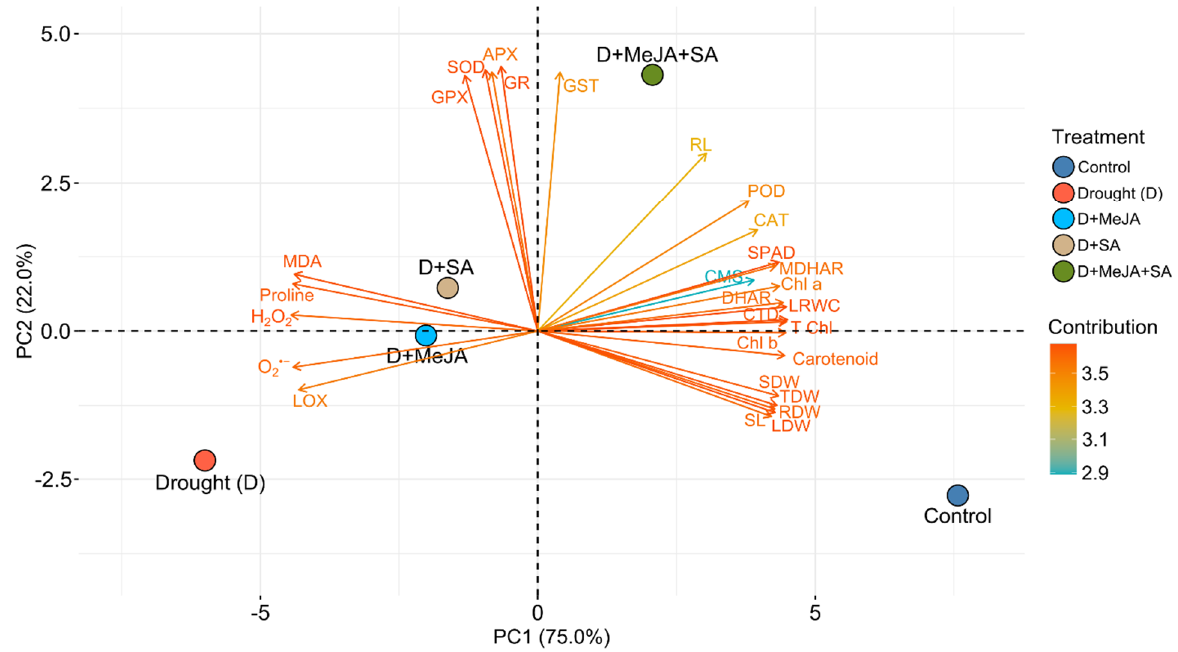
Figure 7. A PCA biplot stipulates the relationship between treatments and observed parameters. Parameters are distributed in different ordinates depending on the divergence among them. In this biplot, the length and color intensity of a vector indicate the quality of representation and the contribution of the traits to the principal components, respectively. The angles between the vectors formed from the middle point of the biplots indicate whether the traits interacted positively or negatively. Additional details are shown in Figure 1.